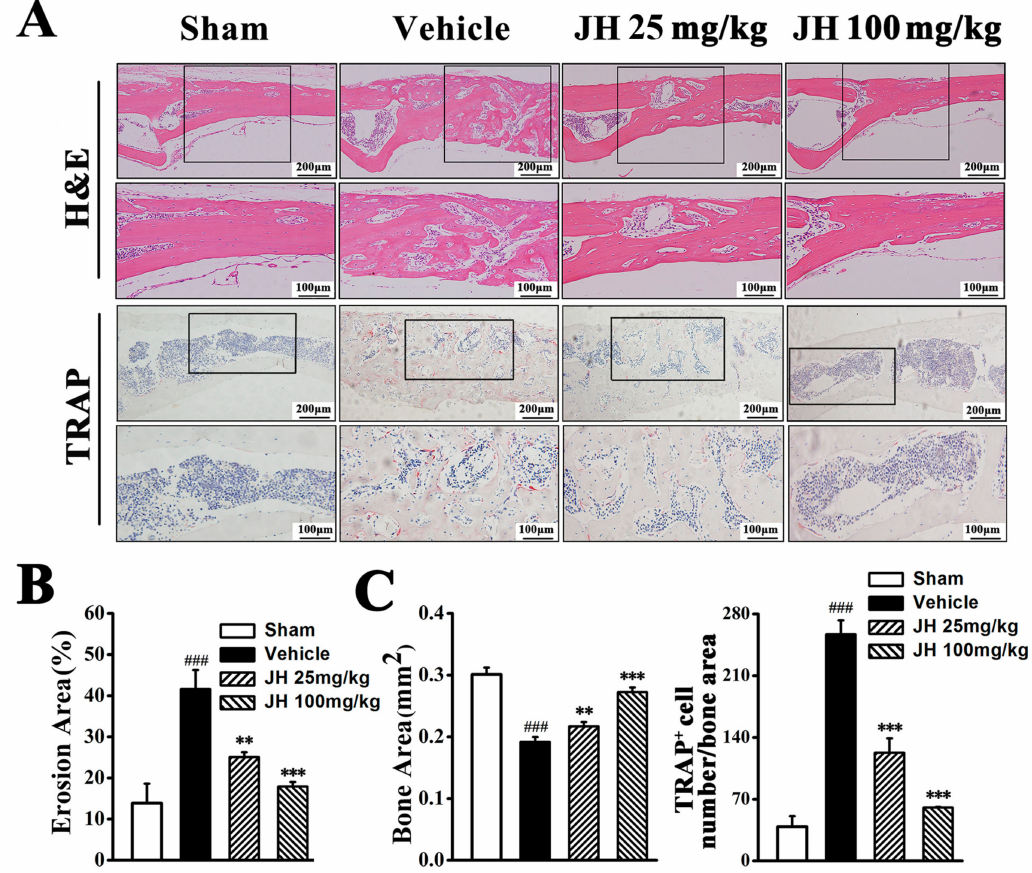
Figure 2. Histological staining and histomorphometric assessment of the inhibitory actions of JH on Ti particle-induced osteolysis. ( A ) Representative micrographs staining for H&E and tartrate-resistant acid phosphatase (TRAP). The regions marked by the black frames were enlarged and shown in the corresponding bottom panels. ( B ) The percentage of total porosity obtained from the H&E-stained sections. ( C ) The bone area (mm 2 ) and TRAP + osteoclast number in TRAP-stained sections were calculated and analyzed as described in the Section 4. All data were shown as mean ± SD; ### p < 0.001 versus sham group, ** p < 0.01 and *** p < 0.001 versus vehicle-treated Ti particle-induced